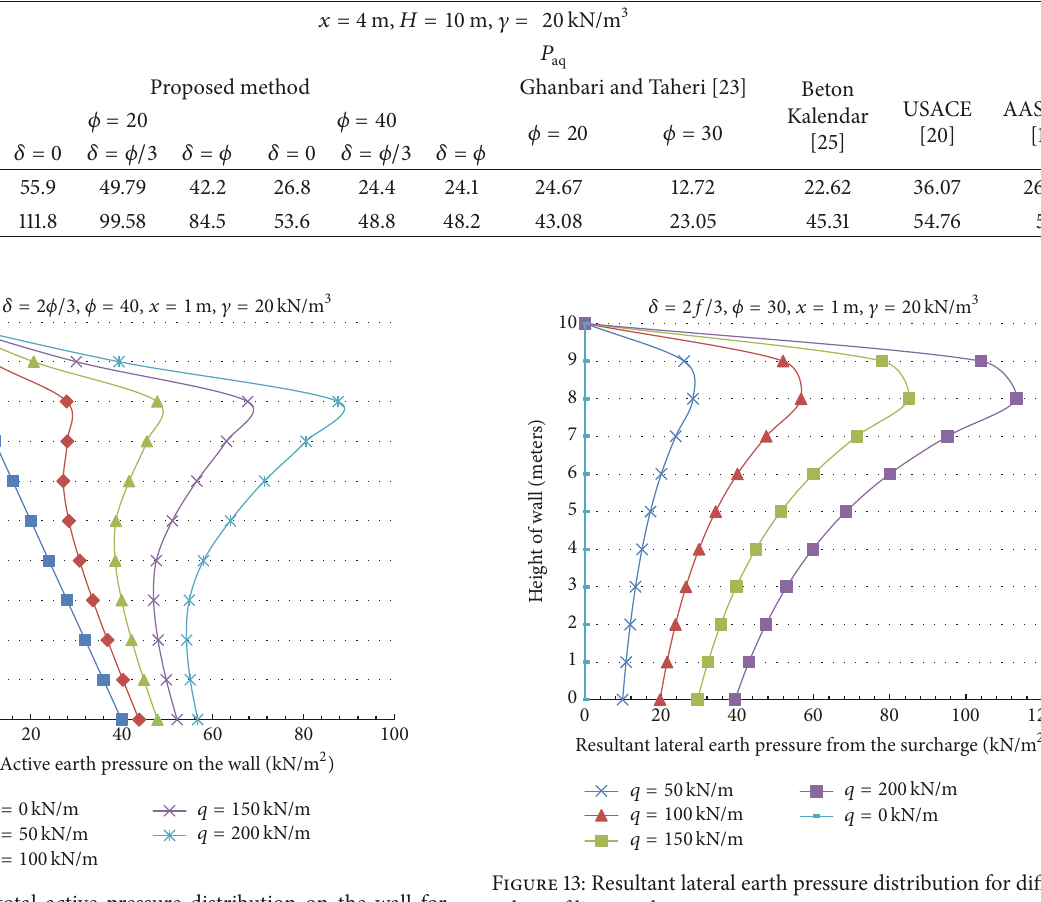
Figure 12: The total active pressure distribution on the wall for different values of line surcharge for 𝜙 = 40 .